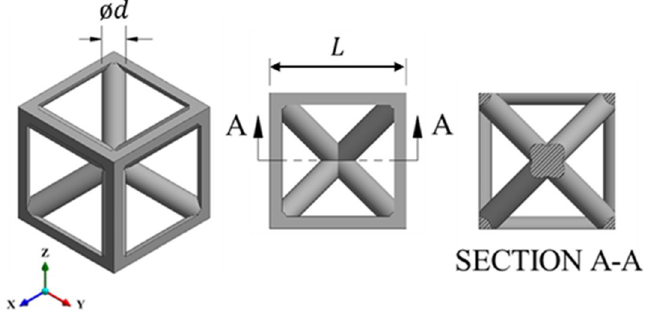
Figure 2. BCC xyz lattice unit cell as designed in CAD with strut diameter d and cell size L .